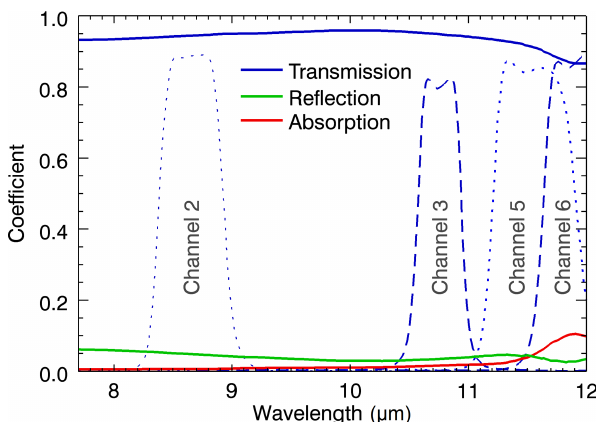
Figure 3. Spectral transmission, reflection, and absorption/emission coefficients of the germanium window for the wavelength range covered by the TIR imager. Included are in addition the response functions (transmission coefficients, dashed–dotted lines) of the four narrow-band